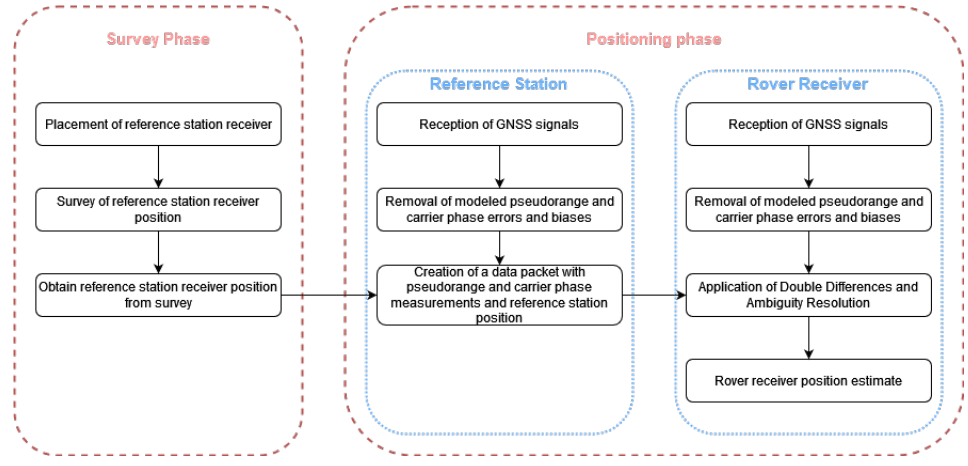
Figure 2. Overview of the RTK positioning